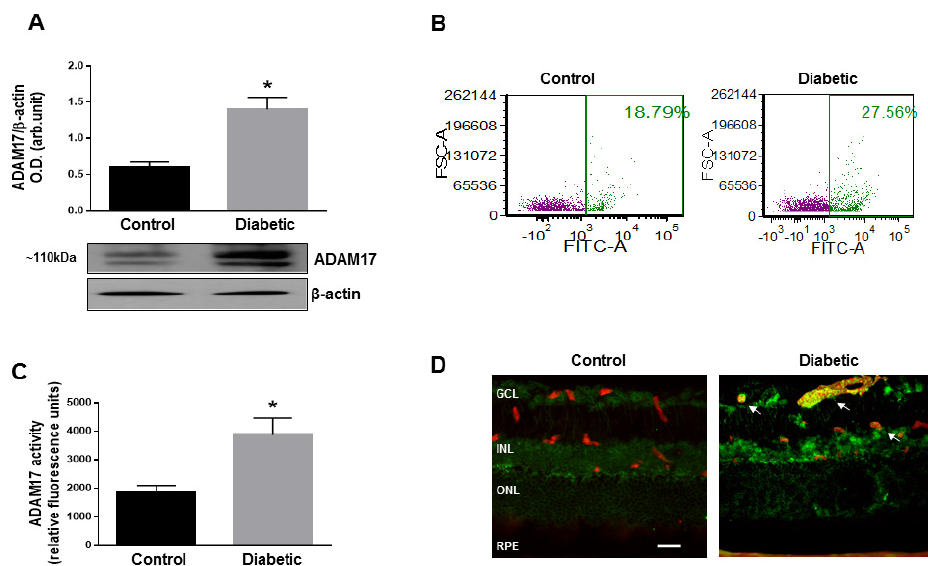
Figure 2. ADAM17 expression in the mouse retina. ( A ) Representative blots and densitometry analysis of ADAM17 expression in normoglycemic (control) and diabetic C57Bl / 6J mice (diabetic) mice at 8 weeks of diabetes. Data presented as mean ± standard error (SE). * p < 0.01. n = 5 per group. ( B ) Flow cytometric analysis of cell surface expression of ADAM17 in retinal single cell suspension from control and diabetic C57Bl / 6J mice at 8 weeks of diabetes. n = 3 pooled retinas per group. ( C ) ADAM17 enzyme activity measured by fluorimetric assay in control and diabetic retinas of C57Bl / 6J mice. Data presented as mean ± SE. * p < 0.01. n = 5 per group. ( D ) Representative images of ADAM17 specific immunoreactivity (green) in retinas of control and diabetic C57Bl / 6J mice at 8 weeks of diabetes. Anti-CD31 antibody (red) was used to co-label endothelial cells. Arrows indicate coexpression of ADAM17 and CD31. GCL, ganglion cell layer; INL, inner nuclear layer; ONL, outer nuclear layer; RPE, retinal pigment epithelial cells. Scale bar, 50 μ m.